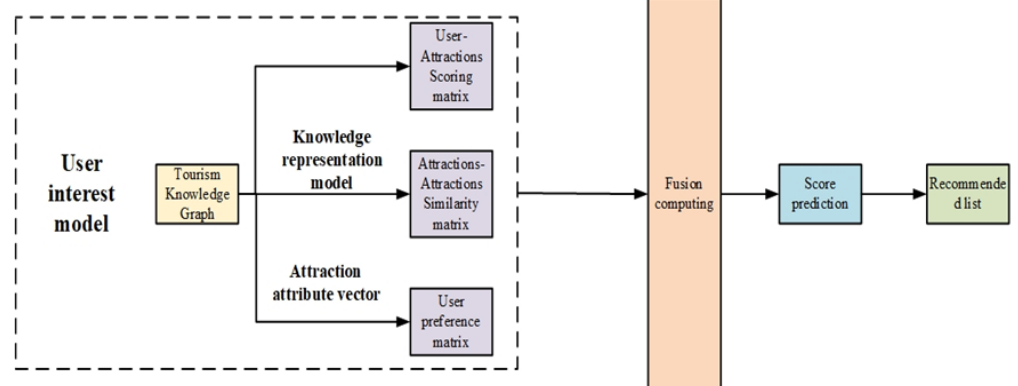
Figure 4. Recommended